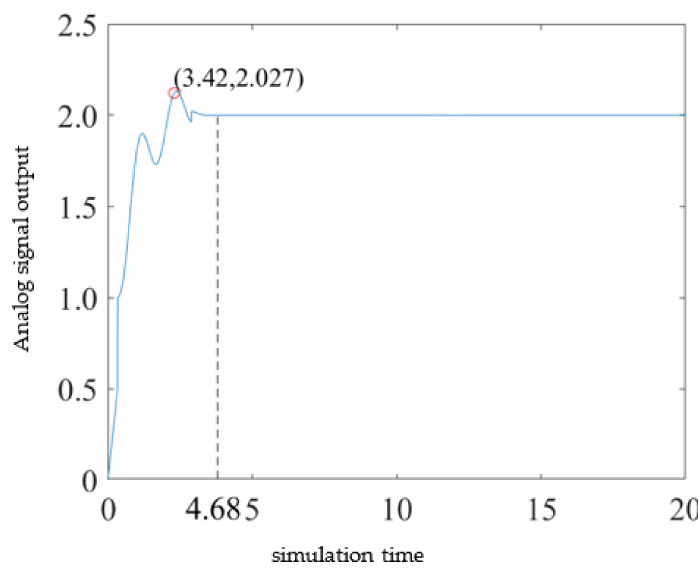
Figure 15. GA–BPNN–PID control system simulation